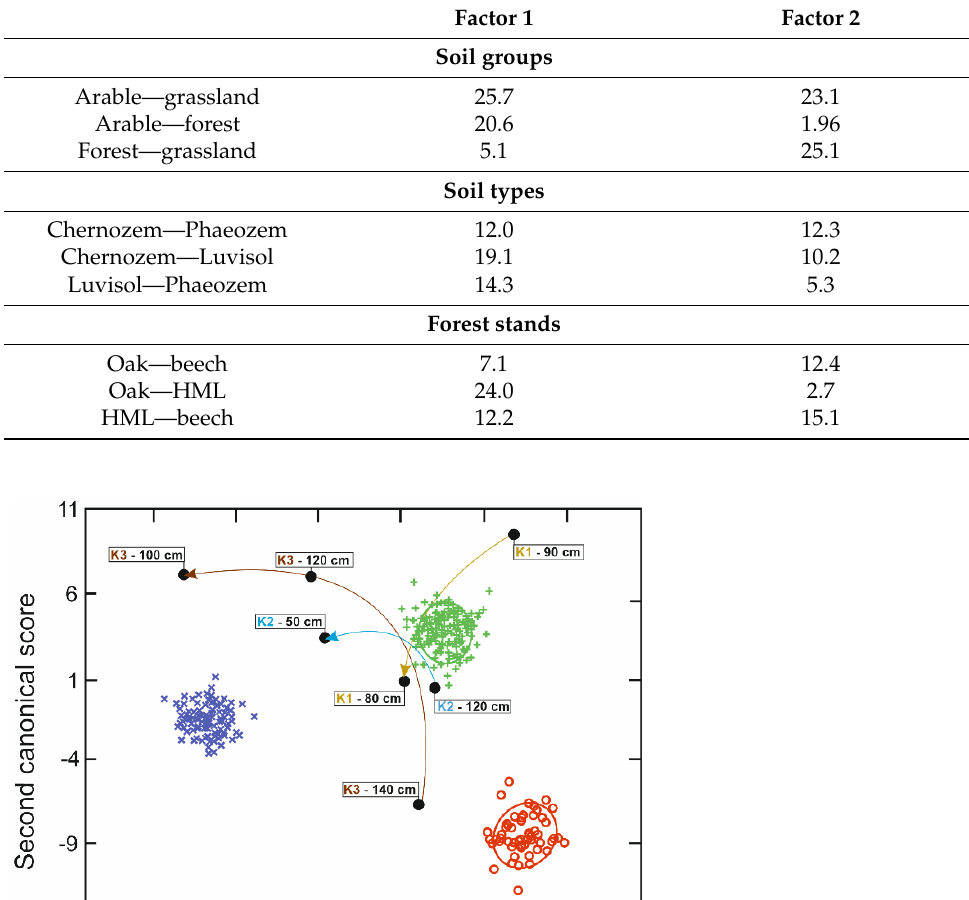
Table 1. Mahalanobis distances between groups depending on the land use, soil reference group and forest stands.